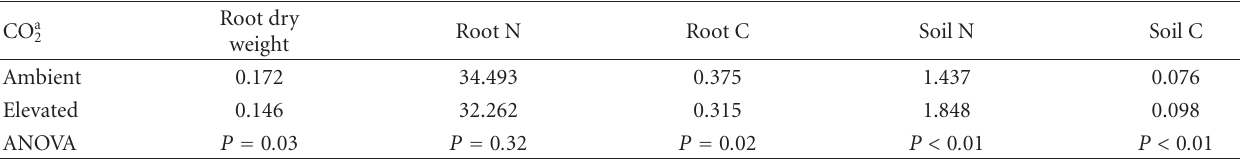
Table 2: Specific respiration rates (gC respired per g) for root biomass, root C and N and soil C and N. Root dry CO a 2 Root